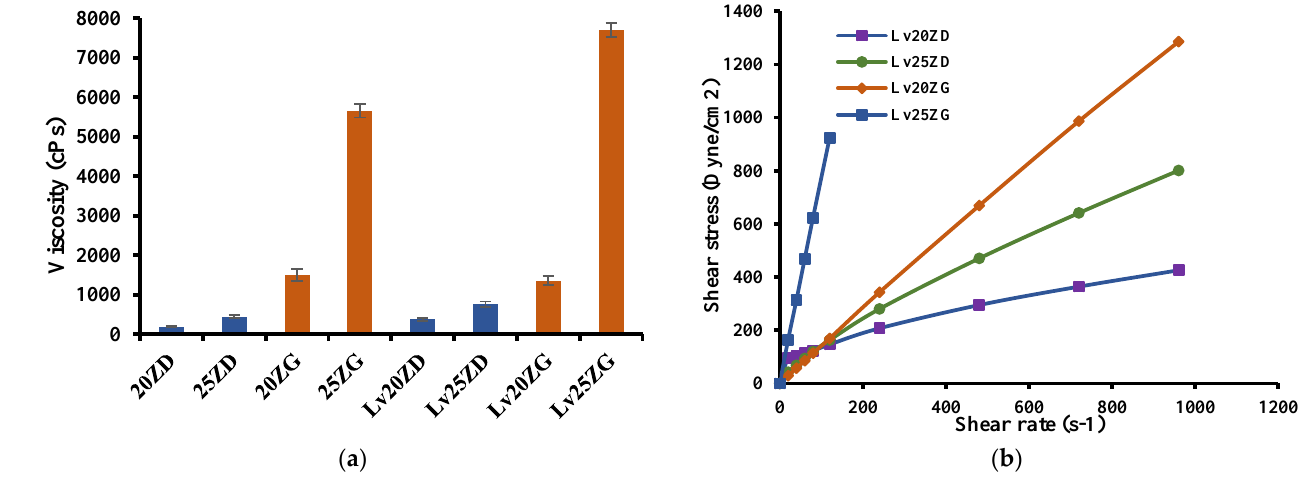
Figure 2. Viscosity ( a ) and relationship between shear stress and shear rates ( b ) of zein-loaded ISG formulations at 25 °C. The data is represented in triplicate.